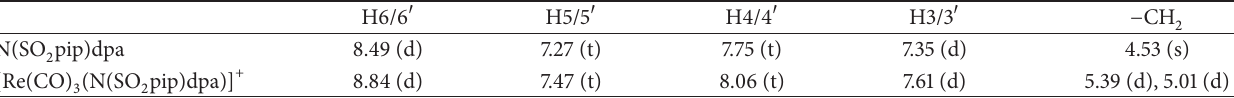
Table 6: Comparison of the 1 H NMR shifts of N(SO 2 pip)dpa ligand and [Re(CO) 3 (N(SO 2 pip)dpa)] + complex in DMSO- 𝑑 6 .